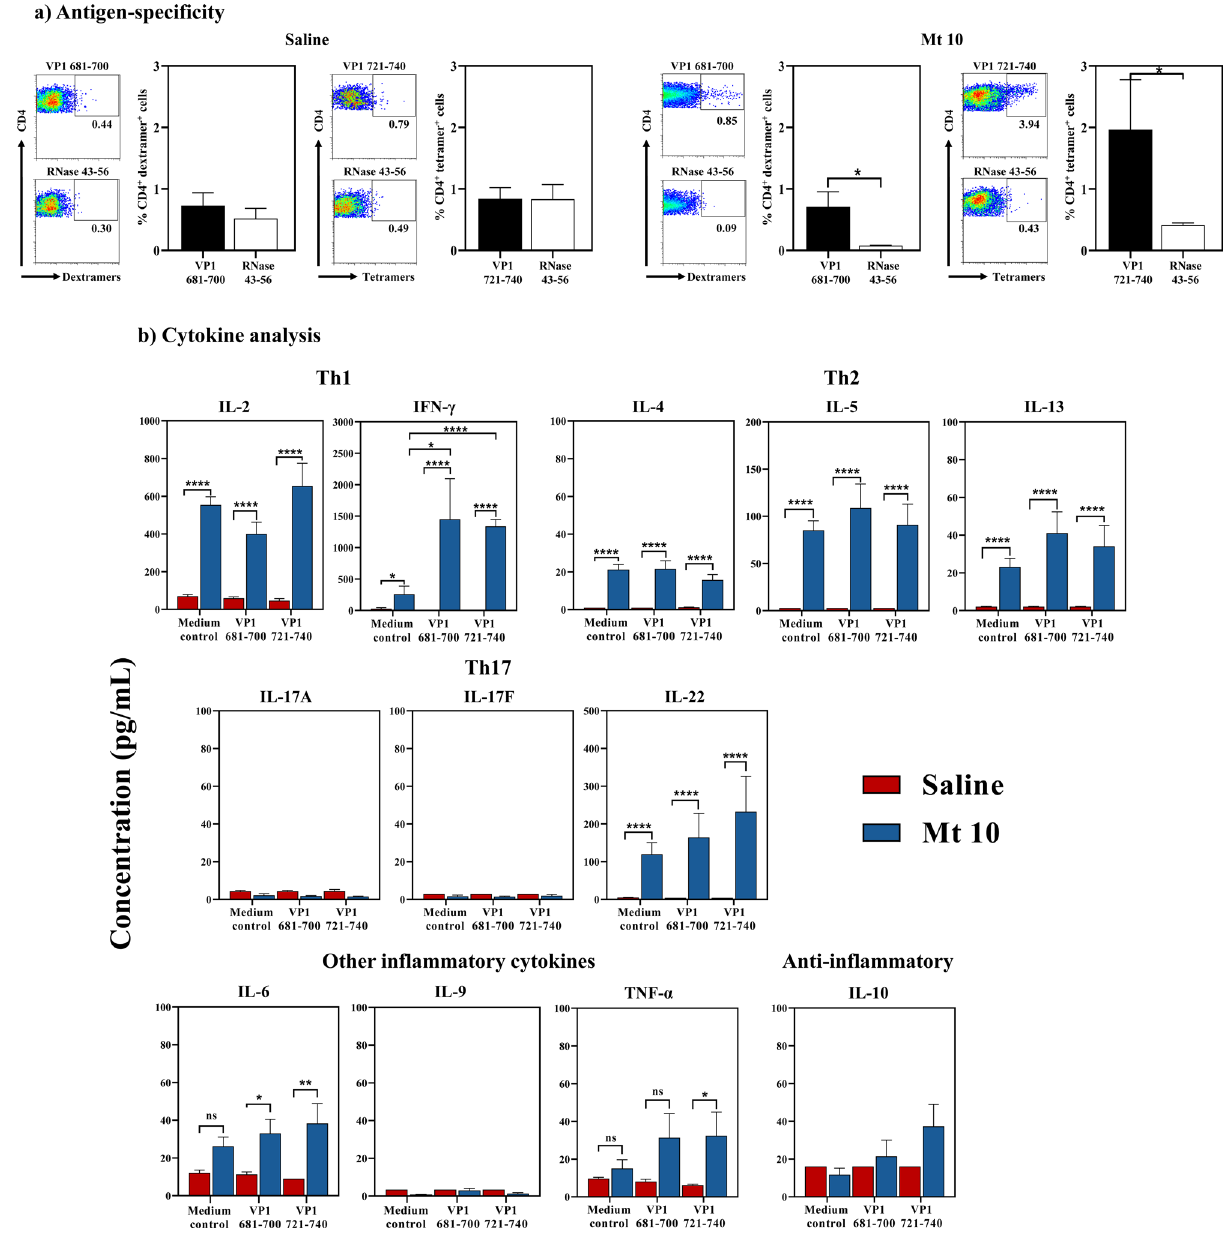
Figure 6. Mt 10 virus induces the generation of antigen-specific, T cells capable of producing predominantly, IFN-γ. ( a ) Antigen-specificity. Groups of mice were injected with saline or Mt 10 virus, and 35 days later, lymphocytes were prepared. Cells were stimulated with VP1 681–700 or 721–740 and maintained in IL-2 medium. Cells harvested between days, 7–10 post-stimulation were stained with the indicated IA k /tetramers and dextramers, anti-CD4 and 7-AAD. After acquiring the cells by flow cytometry, tetramer and dextramer + cells were analyzed in the live (7-AAD¯) CD4 subset using FlowJo software. RNase 43–56, control. Representative flow cytometric dot-plots and the mean ± SEM values from three individual experiments, each involving n = 3 to 8 mice are indicated. ( b ) Cytokine analysis. Supernatants harvested from the above cultures on day 3 post- stimulation were analyzed for cytokines by LEGENDplex cytokine bead array as described in the methods section. Mean ± SEM values obtained from three individual experiments, each involving n = 3 to 8 mice are indicated. Unpaired Student’s t-test (two-tailed) was used to determine significance between groups [for panels ( a , b )]. * p ≤ 0.05, ** p ≤ 0.01, and **** p ≤